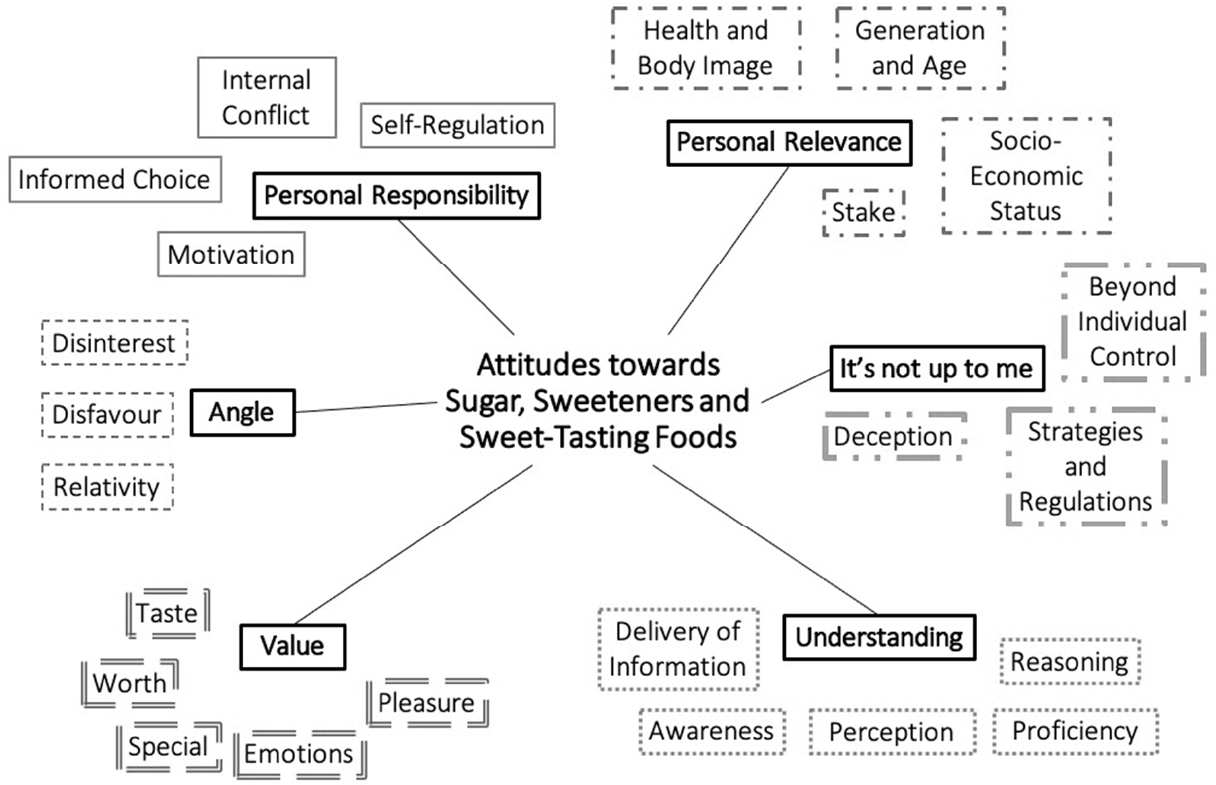
Figure 1. Attitudes towards sugar, sweeteners and sweet-tasting foods: themes and subthemes.